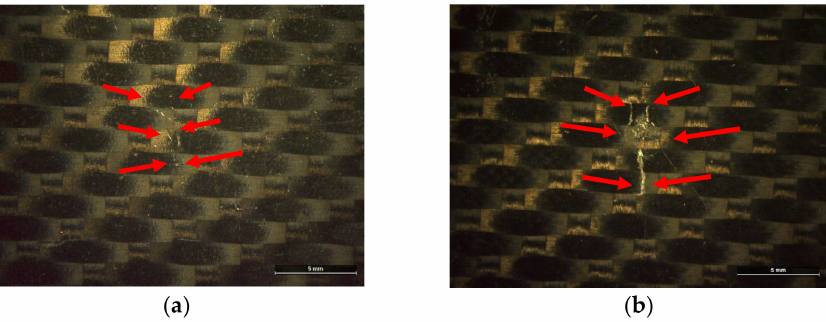
Figure 8. Microscopic images of the back faces of ( a ) panel 13 and ( b ) panel 15.